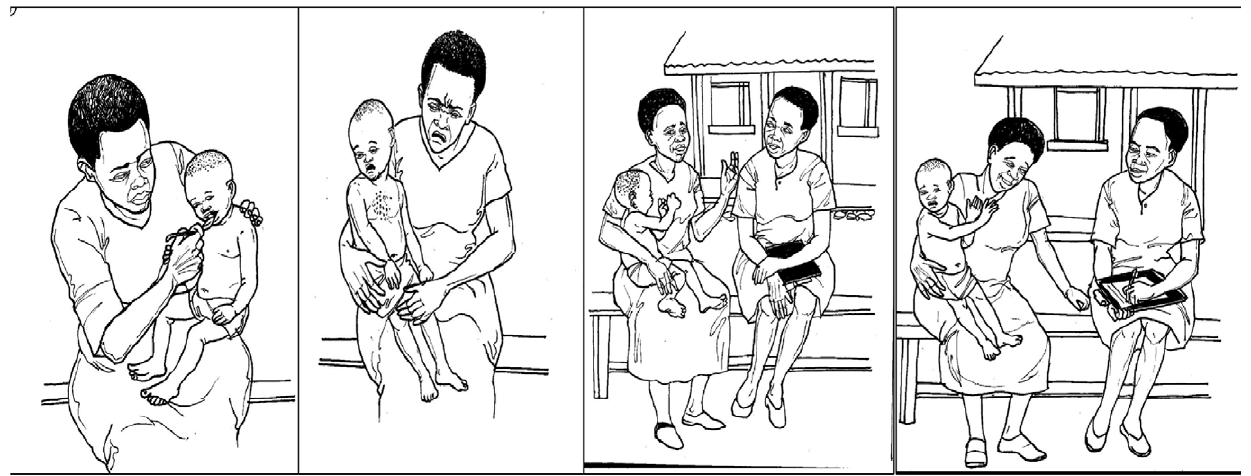
Figure 2. Pictorial strip first draft, demonstrating reporting of a child’s adverse event.